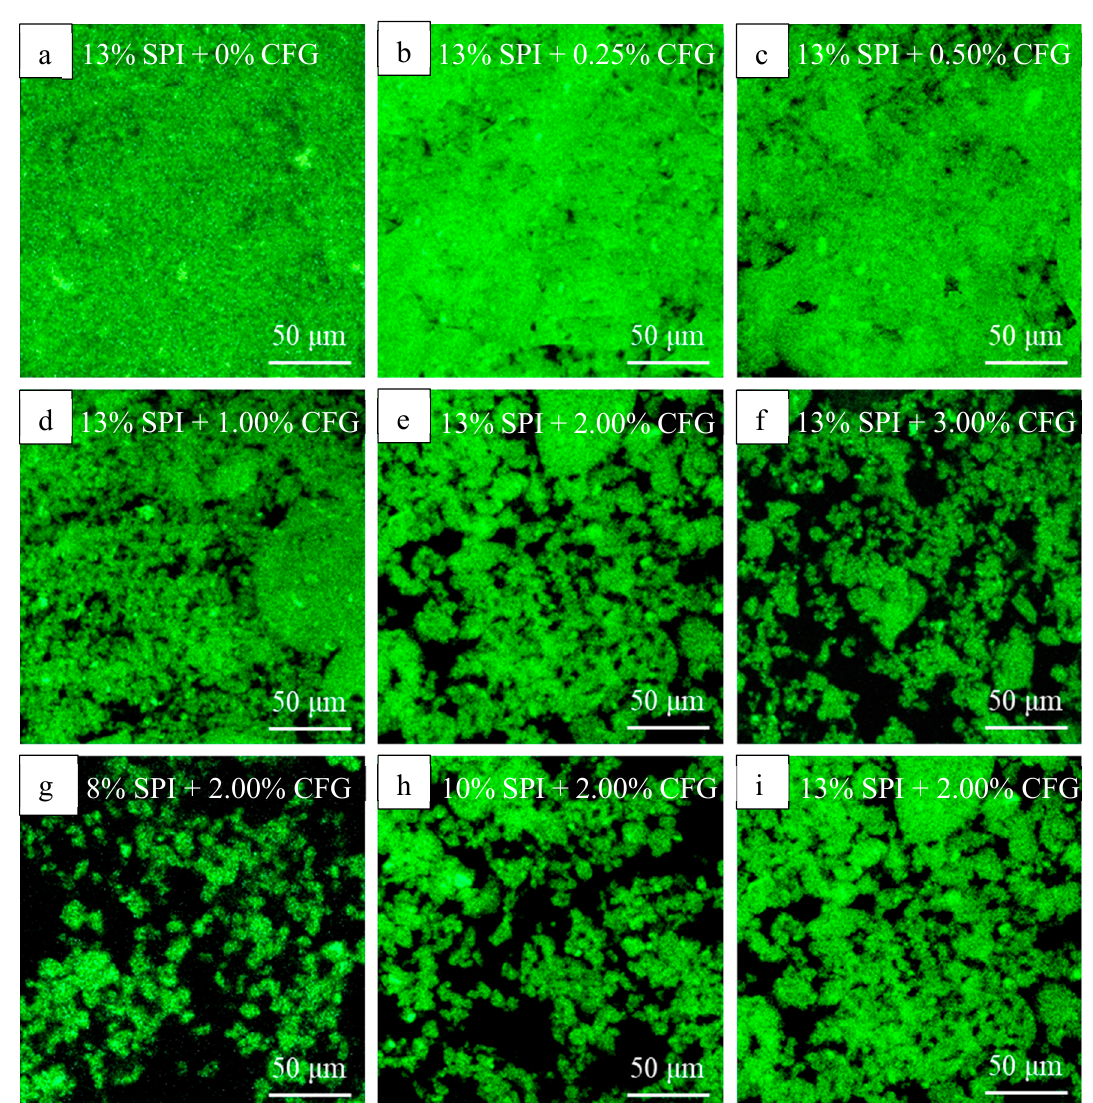
Figure 1. CLSM images of CFG-SPI DN hydrogels. 13% of SPI with various concentrations of CFG (( a ) 0%; ( b ) 0.25%; ( c ) 0.5%; ( d ) 1%; ( e ) 2%; ( f ) 3%, ( w / v )). 2% SBP with various concentrations of SPI (( g ) 8%; ( h ) 10%; ( i ) 13%, ( w / v )).